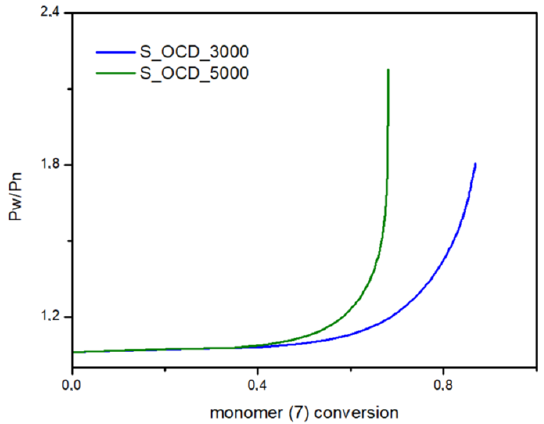
Figure 16. The number average molar mass (P n ) and the weight average molar mass (P w ) as a func- tion of conversion of the 1,10-decanediol added in second stage of synthesis.